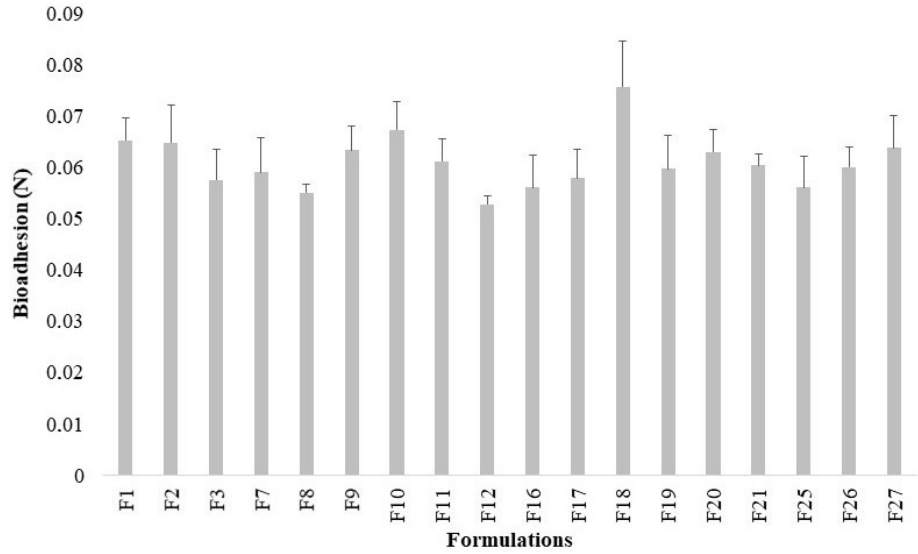
Figure 6. Effect of polymeric content, vegetable oils and different bioactive agents in bioadhesion of the emulsion systems at 34 °C. The plots represent the mean plus standard deviation, and the relative standard deviation was less than 12% (n = 3).